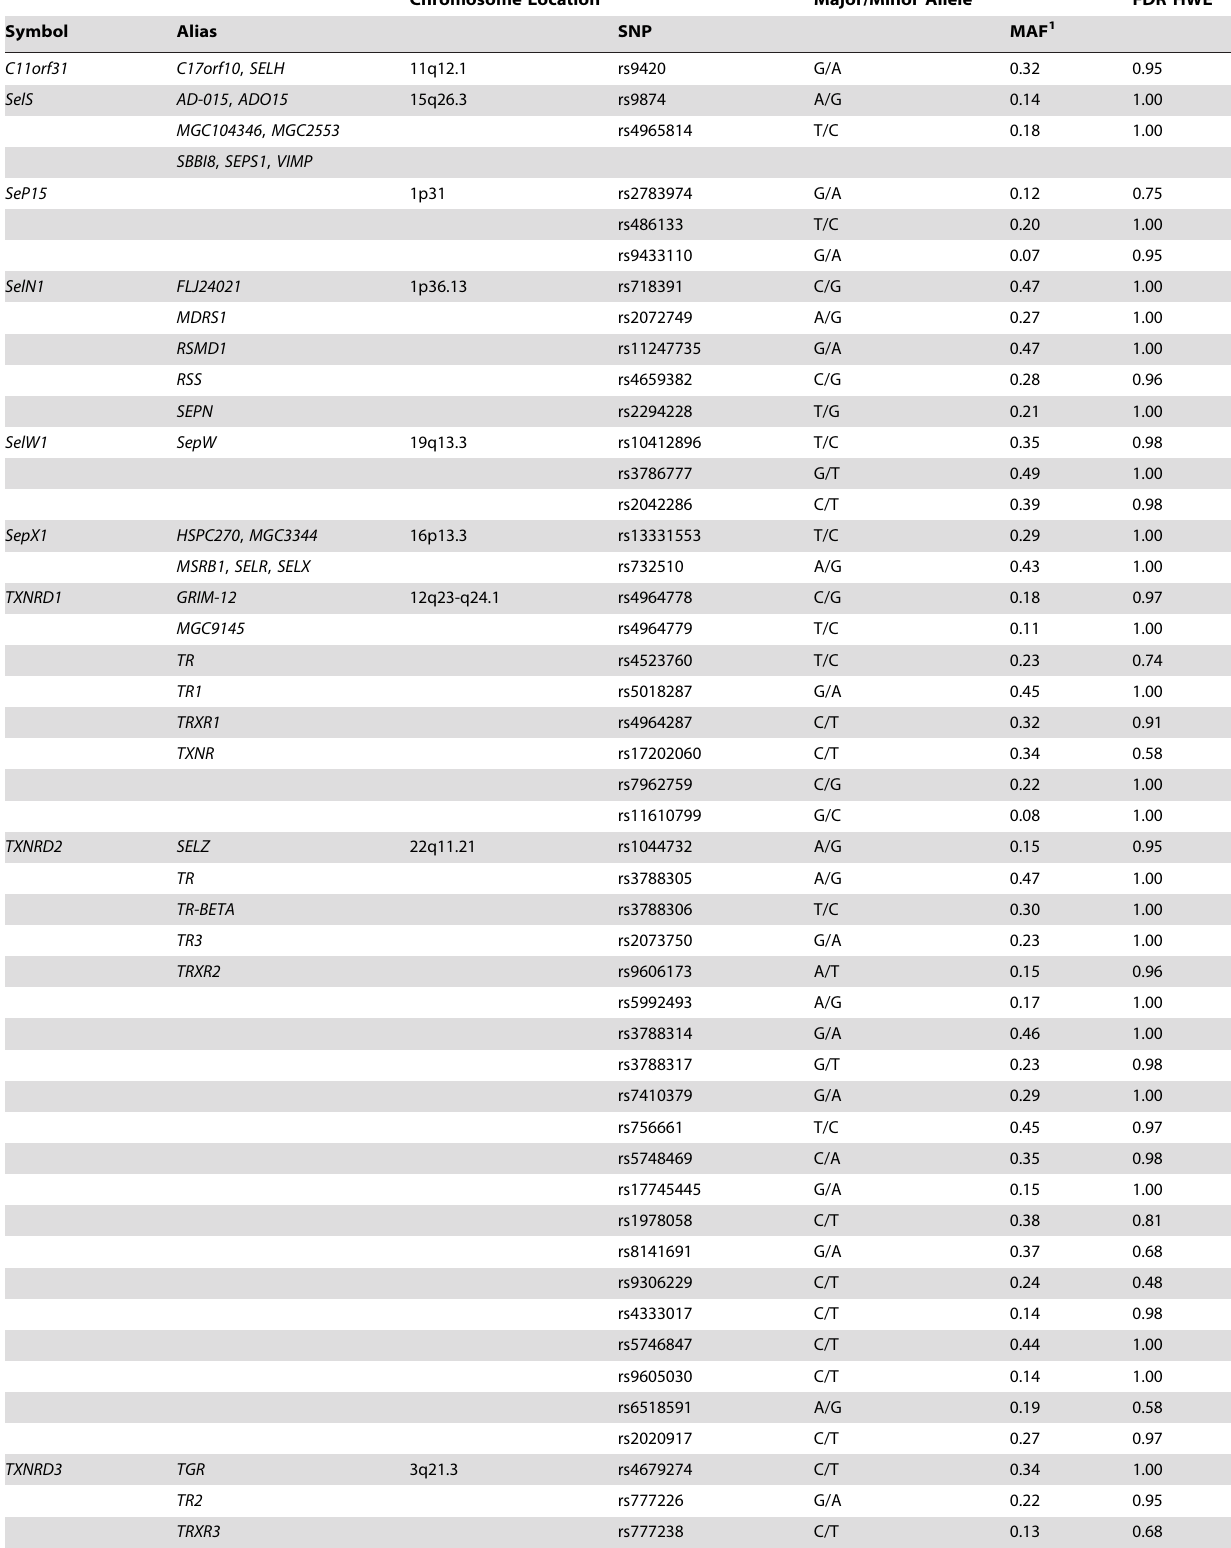
Table 1. tagSNPs